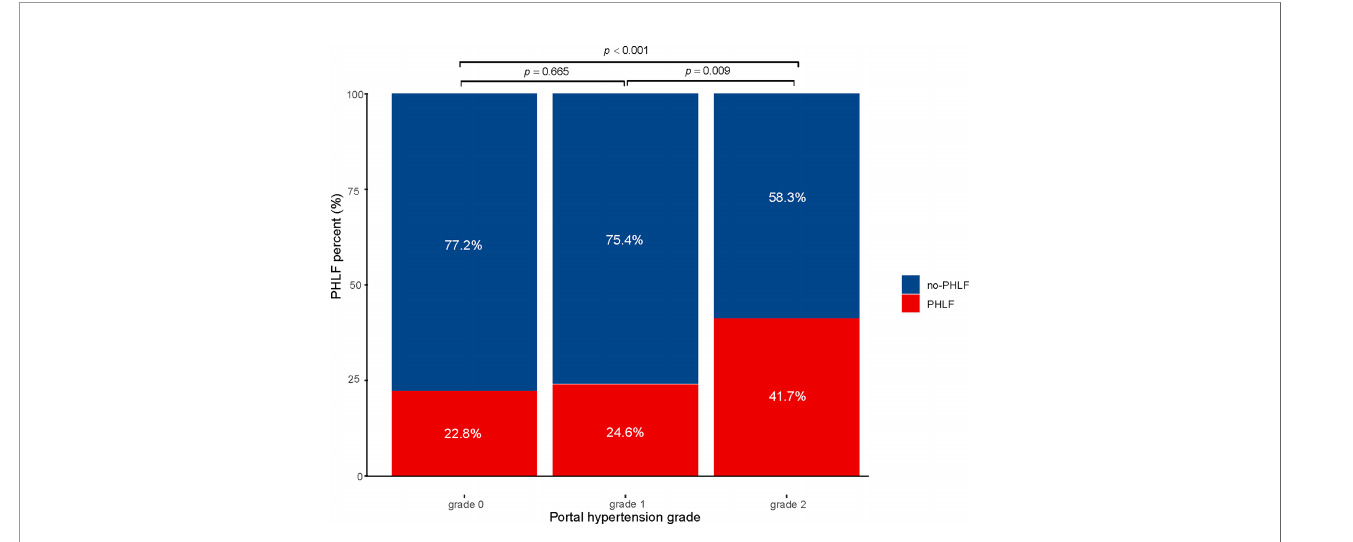
FIGURE 1 | Incidence of PHLF with small-scale liver resection in patients with hepatocellular carcinoma PHLF, post hepatectomy liver